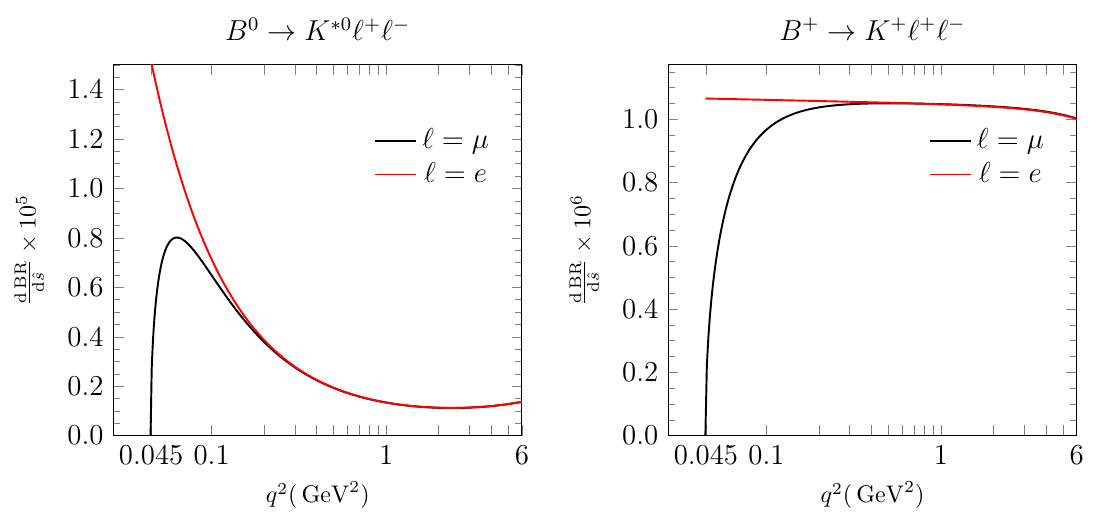
Figure 2 . Distributions for the di(cid:11)erential branching ratio d BR a function of q 2 (the invariant mass square of the dilepton (cid:12)nal state), for the l = (cid:22) (black) and l = e (red) cases. Left and right plots correspond to the B ! K (cid:3) ‘ + ‘ (cid:0) and B ! K‘ + ‘ (cid:0) decays respectively. These results correspond to the parametrization of form factors and input values as reported in the